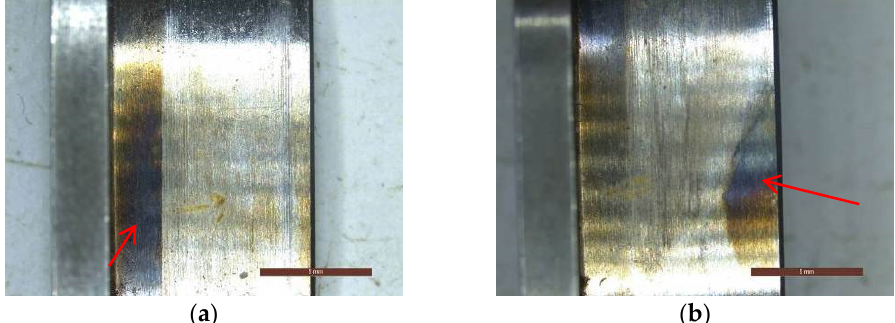
Figure 7. Discolouration on the outer diameter surface of the outer ring, as the arrow indicated: ( a ) discolouration corresponded to the bearing side with laser marking; ( b ) discolouration corre- sponded to the bearing side with laser marking.